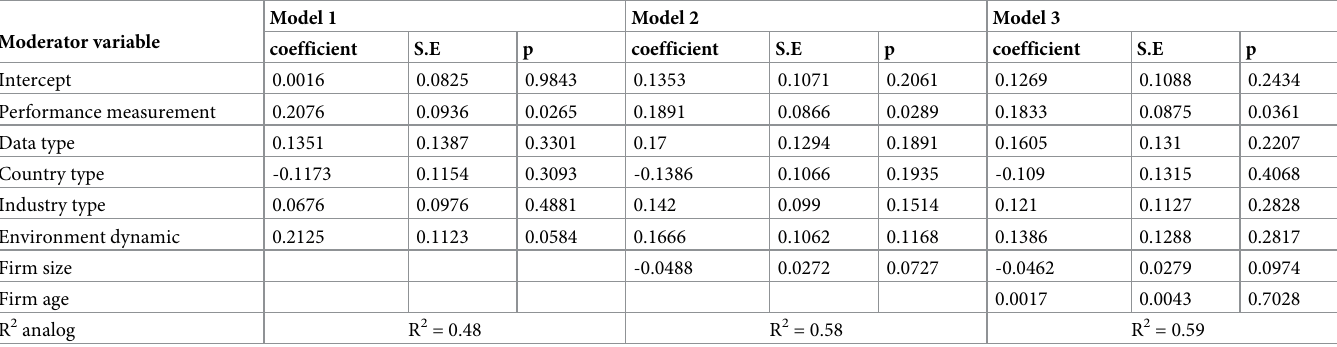
Table 3. Results of meta-regression